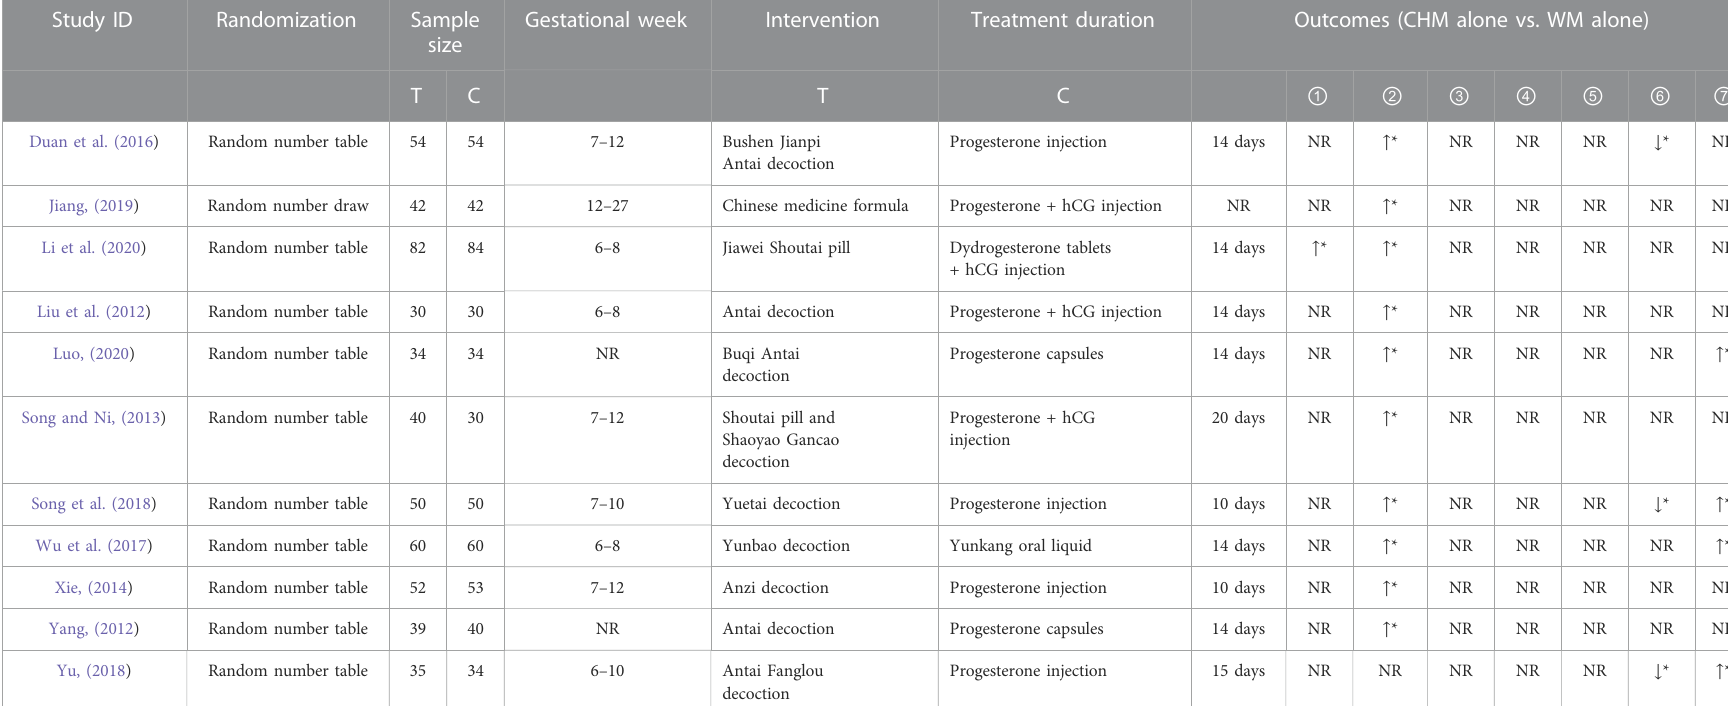
TABLE 1 Study characteristics for included studies of CHM alone vs. WM